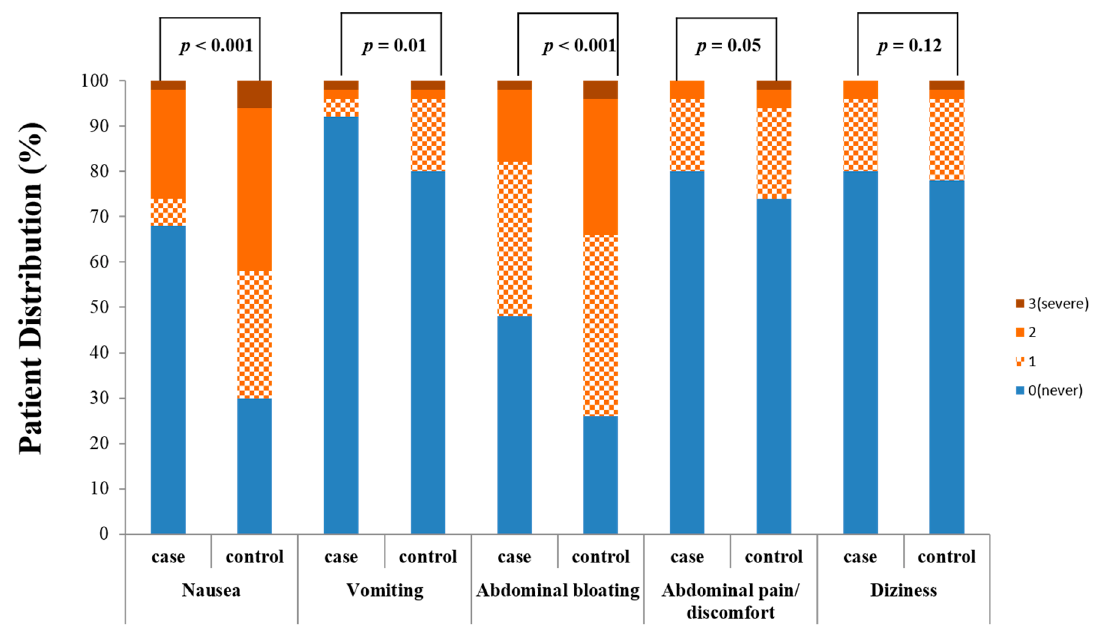
Figure 1. Patient safety profiles for the bowel preparation agents.